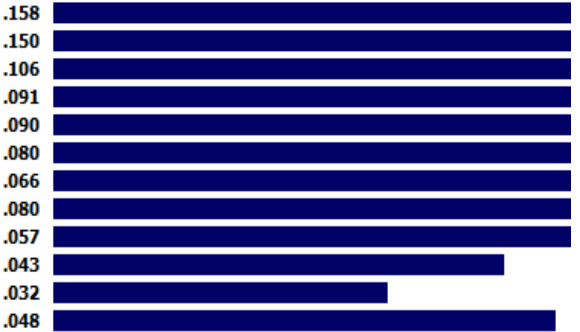
Fig. 4. Supplier ratings for category A components.